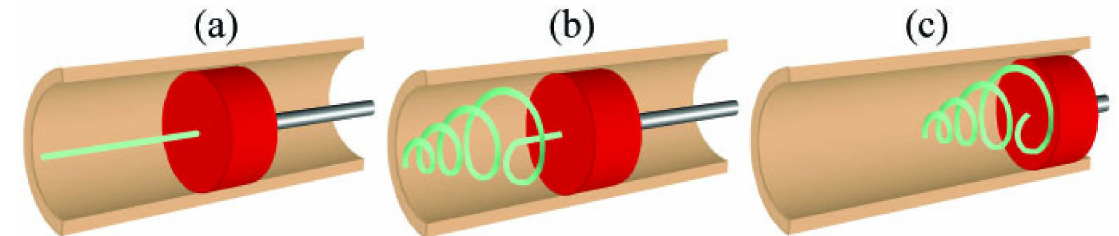
Figure 13. Representation of endovascular thrombectomy using the laser activated shape memory polymer micro actuator attached to an optical fiber. ( a ) In its secondary straight rod form, the micro actuator is delivered through a catheter distal to the thrombotic vascular occlusion. ( b ) Primary corkscrew form of micro actuator induced by laser heating. ( c ) The deployed micro actuator is retracted to capture the thrombus. (Reproduced with permission from [100] Copyright 2005, The Optical